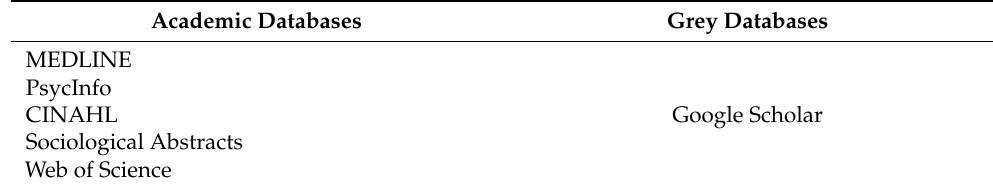
Table 2. Academic and grey literature databases used to search eligible studies.